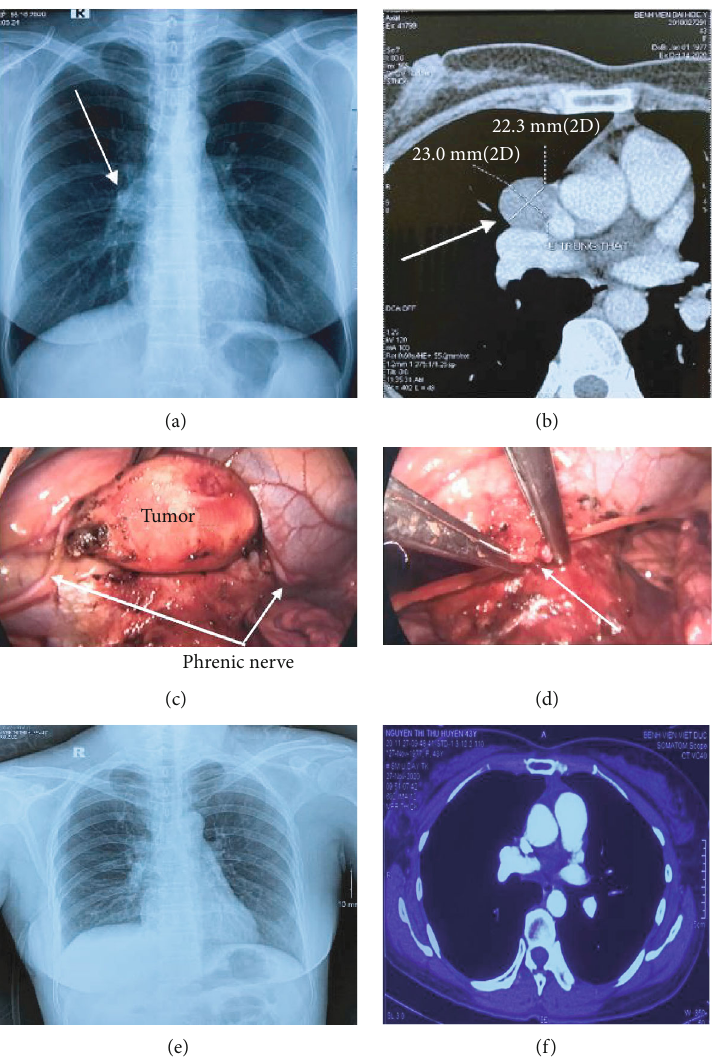
Figure 1: Preoperative, intraoperative, and postoperative images: (a) preoperative chest X-ray (arrow); (b) the middle mediastinal tumor (arrow); (c) intraoperative tumor and the right phrenic nerve (arrow); (d) removed tumor image (arrow); (e) postoperative chest X-ray; (f) the chest CT scanner 1 month after